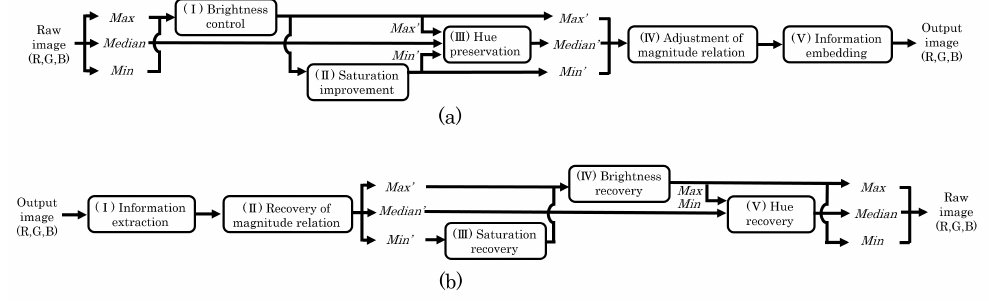
Figure 2. Block diagrams of proposed method. ( a ) Image processing. ( b ) Raw image